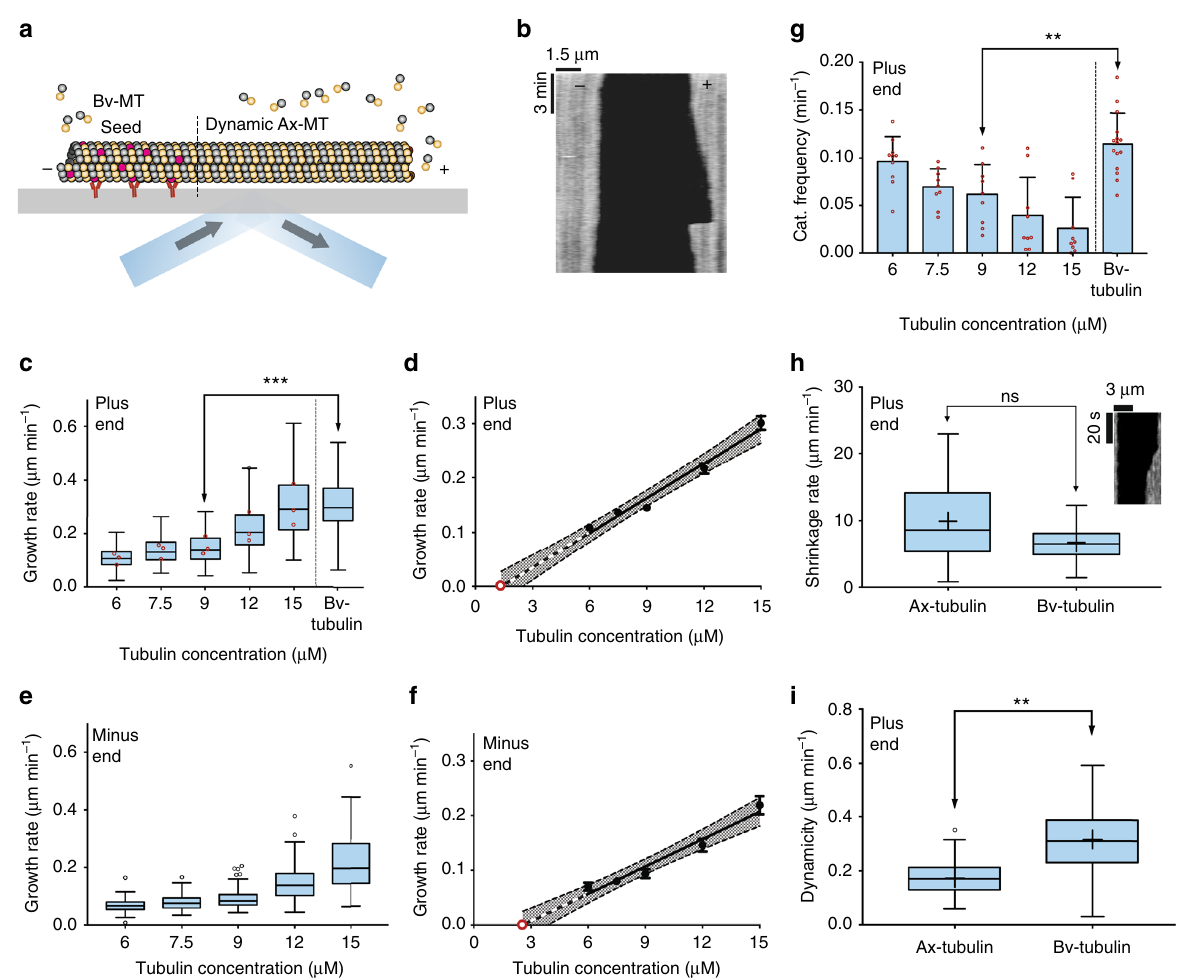
Fig. 2 Polymerization dynamics of axonemal microtubules. a Schematic of the experimental design. Axonemal MTs grow from GMPCPP-stabilized TAMRA-labeled bovine brain MT seeds, which are immobilized to the coverslip with anti-TAMRA antibodies. b Representative kymograph of axonemal MT growth imaged using interference re fl ection microscopy. c Tukey plot showing growth rates of axonemal MTs in different tubulin concentrations. Each red circle marks the mean growth rate of a single biological replicate ( n = 275, 280, 268, 252, 265, 542 total number of MTs used at the different concentrations; *** p = 0.0003, determined by a two-tailed t test, 9 independent experiments for each tubulin concentration from three independent axonemal tubulin puri fi cations). d The mean growth rates at different tubulin concentrations from panel (c) were fi t by linear regression. No growth is observed below 6 μ M and the x -intercept (red open circle) is 1.35 μ M. Grey area denotes 95% con fi dence interval. Error bars represent SEM. e Tukey plot showing growth rates at the minus end of axonemal MTs in different tubulin concentrations ( n = 48, 60, 73, 96, 126). f The mean growth rates at different tubulin concentrations from panel (e) were fi t by linear regression. The extrapolated concentration is 2.6 μ M. Grey area denotes 95% con fi dence interval. g Bar plot showing catastrophe frequency of axonemal MTs at different tubulin concentration and bovine brain tubulin at 9 μ M (Error bars represent SD for n = 10, 9, 9, 9, 9, 15; ** p = 0.0027, determined by a two-tailed t test). h Tukey plot showing the shrinkage rates of axonemal MTs and bovine brain MTs at 9 μ m tubulin concentration ( n = 9 independent experiments with a total of 111, 211 MTs). Inset: kymograph showing a typical shrinkage event. i Tukey plot showing the dynamicity of axonemal MTs and bovine brain MTs at 9 μ M tubulin concentration (a total of 75 MTs were analyzed in each of the two tubulins; ** p = 0.001, determined by a two-tailed t test, 9 independent experiments for each tubulin concentration). For all Tukey plots, middle line represents the median, plus sign indicates the mean. Source data are provided as a Source Data fi le